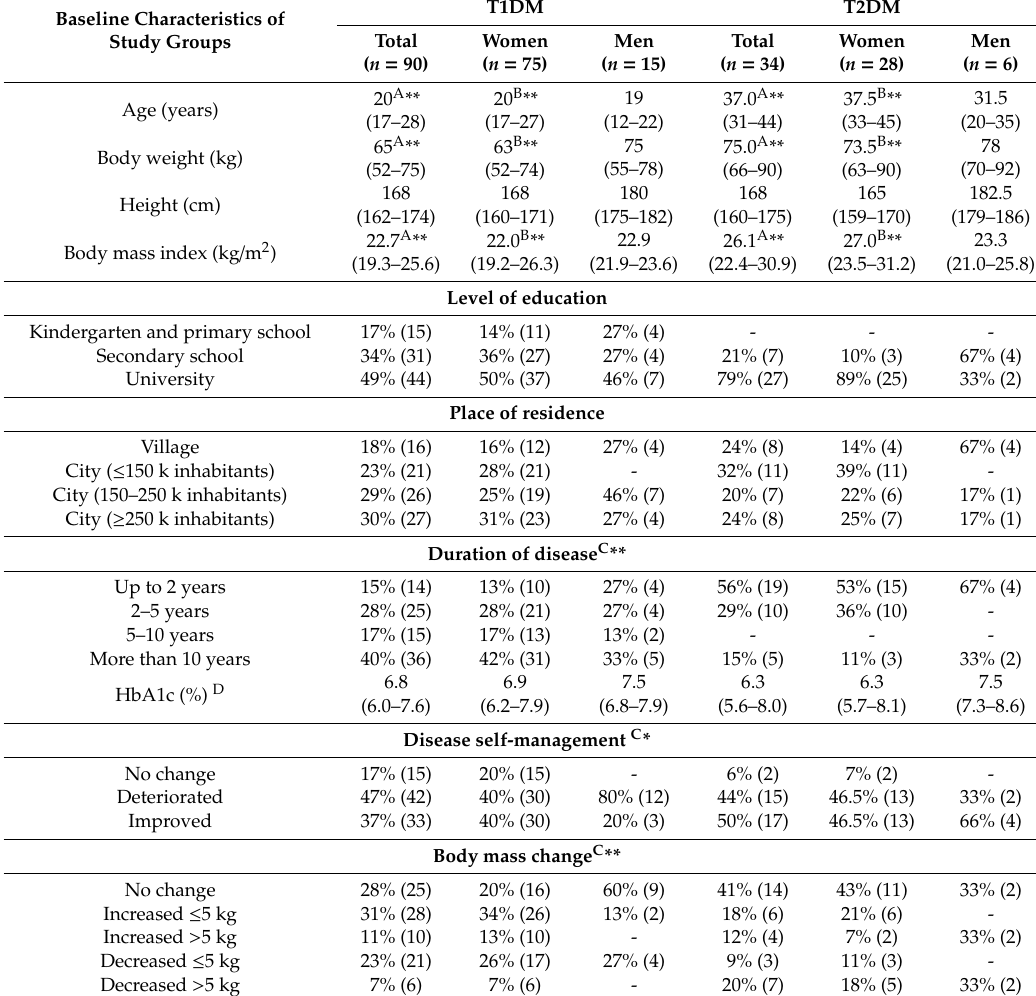
Table 1. Baseline characteristics of study groups.